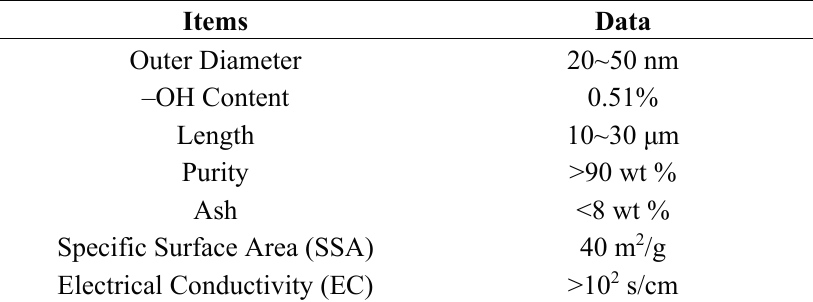
Table 2. Properties of